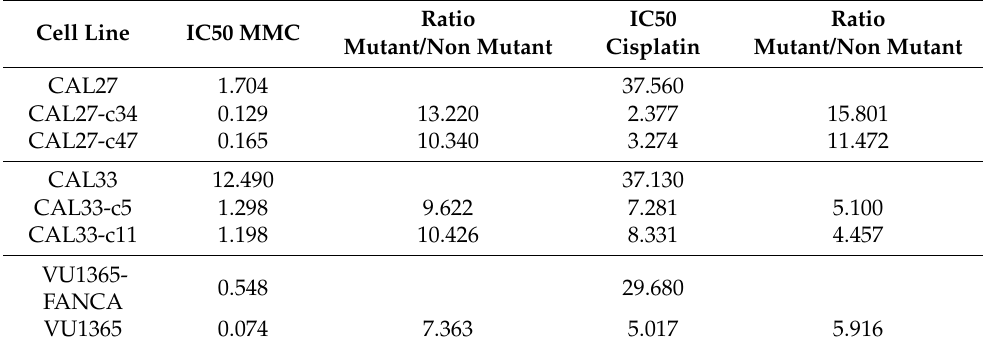
Table 1. Half-maximal inhibitory concentration (IC50) values for mitomycin C (MMC) and cis- platin